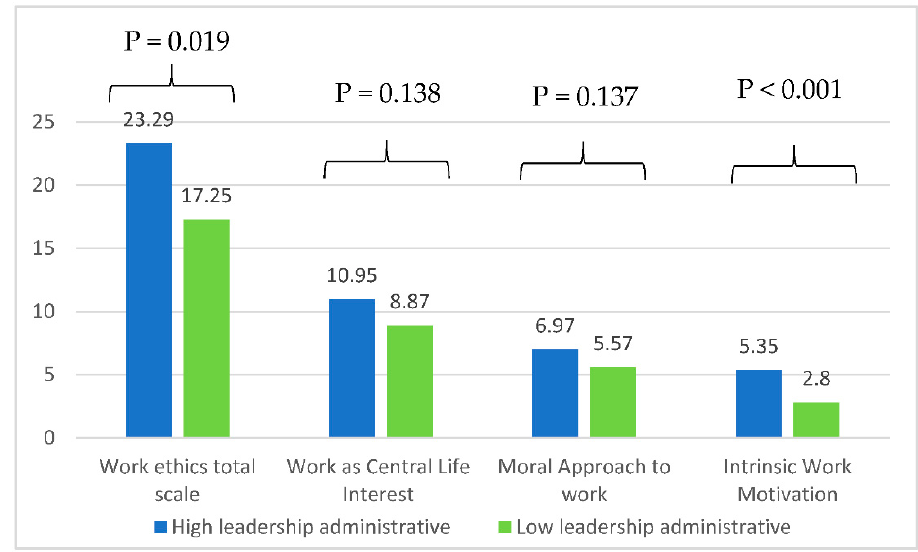
Figure 1. Mean values of the work ethics scale according to high/low administrative leadership skills adjusted for age, gender, education level, and years of experience.